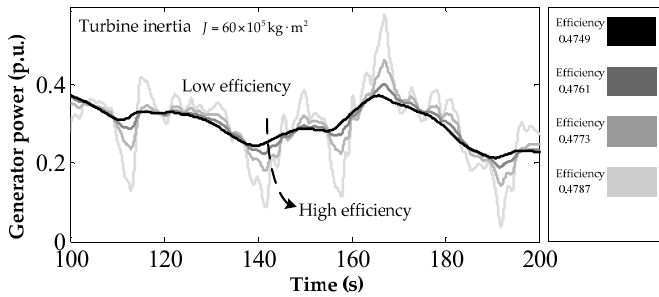
Figure 3. Power fluctuations with different conversion efficiency in the same turbine.